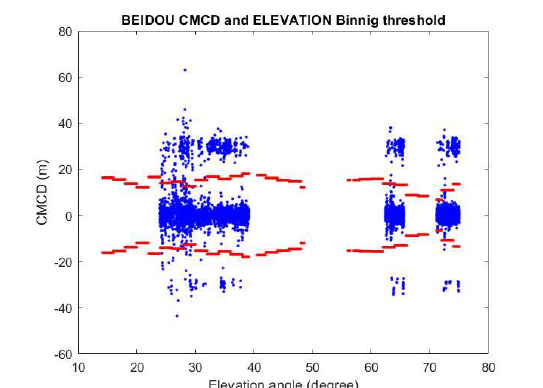
Figure 7. Coloured dots that bigger or smaller values than red values are accepted as BeiDou CMCD measurements (Blue dots are BeiDou CMCDs and red lines are acceptable threshold) In above results, the red lines represent the defined threshold, and the coloured dots represent the estimated values for CMCD. These images are marked based on the elevation angle of each satellite.